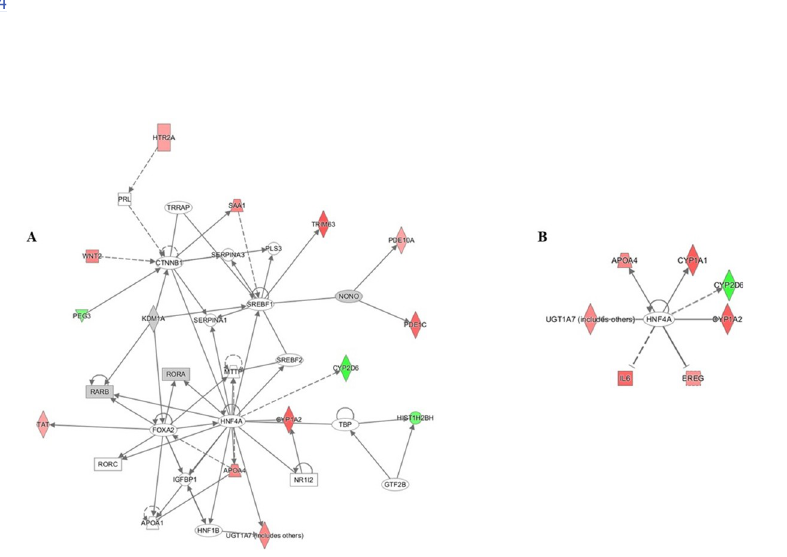
Fig 4. Heatmap of log 2 FC value of differentially expressed genes in the top 5 tox pathways. CYP2D6 has high expression and close association with P1, P3, and P4 pathways pertinent to its normal biological functions in xenobiotics and fatty acid metabolism.